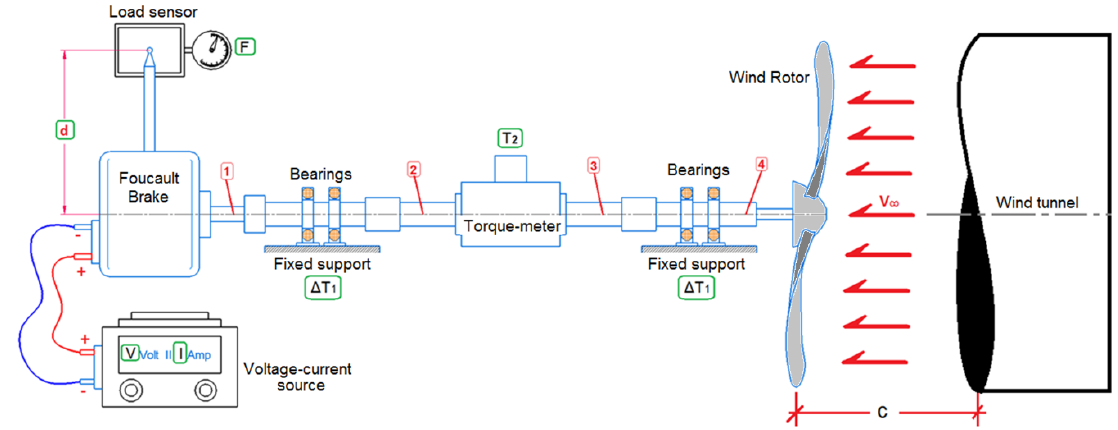
Figure 3. Test bench arrangement scheme.